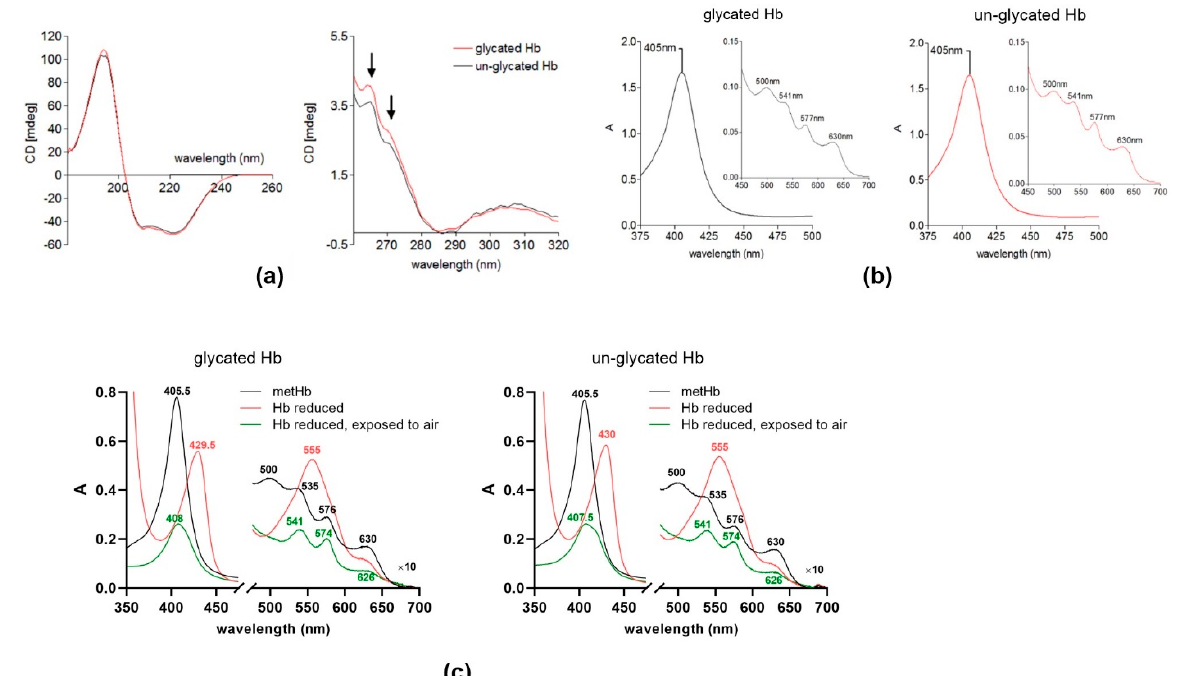
Figure 2. Characterization of glycated hemoglobin. ( a ) (Left) Far- and (right) near-UV CD analysis (averages of 25 repeat scans) of glycated and un-glycated hemoglobin. Both spectra were background-corrected by the subtraction of the buffer spectrum. Arrows in the near-UV region (260–280 nm) denote the wavelengths at which subtle changes were observed in the spectra of the glycated hemoglobin preparations. ( b ) The UV–visible spectra of the glycated (left panel) and un-glycated hemoglobin (right panel) after phenylboronic acid-affinity chromatography purification. ( c ) Comparison of redox properties of heme bound to glycated and un-glycated hemoglobin. Hb, hemoglobin; A, absorbance.